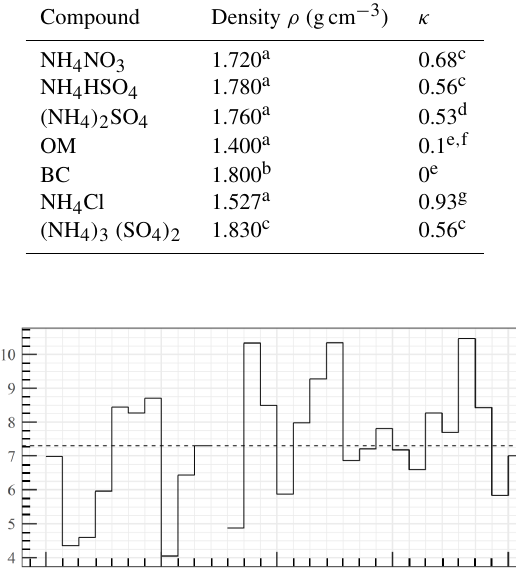
Table A1. Density ρ and hygroscopicity parameter κ of the aerosol compounds to derive the volume fraction of each compound. The densities follow a Lin et al. (2013) and references therein (Tang, 1996; Chazette and Louisse, 2001; Sloane, 1986; Haynes, 2011; Seinfeld and Pandis, 2006; Eichler et al., 2008), b Moteki et al. (2010), c Kreidenweis et al. (2008) and references therein (Tang and Munkelwitz, 1994; Marcolli et al., 2004), d Petters and Krei- denweis (2007), e Wu et al. (2013), f Zaveri et al. (2010), and g Liu et al. (2014). Compound